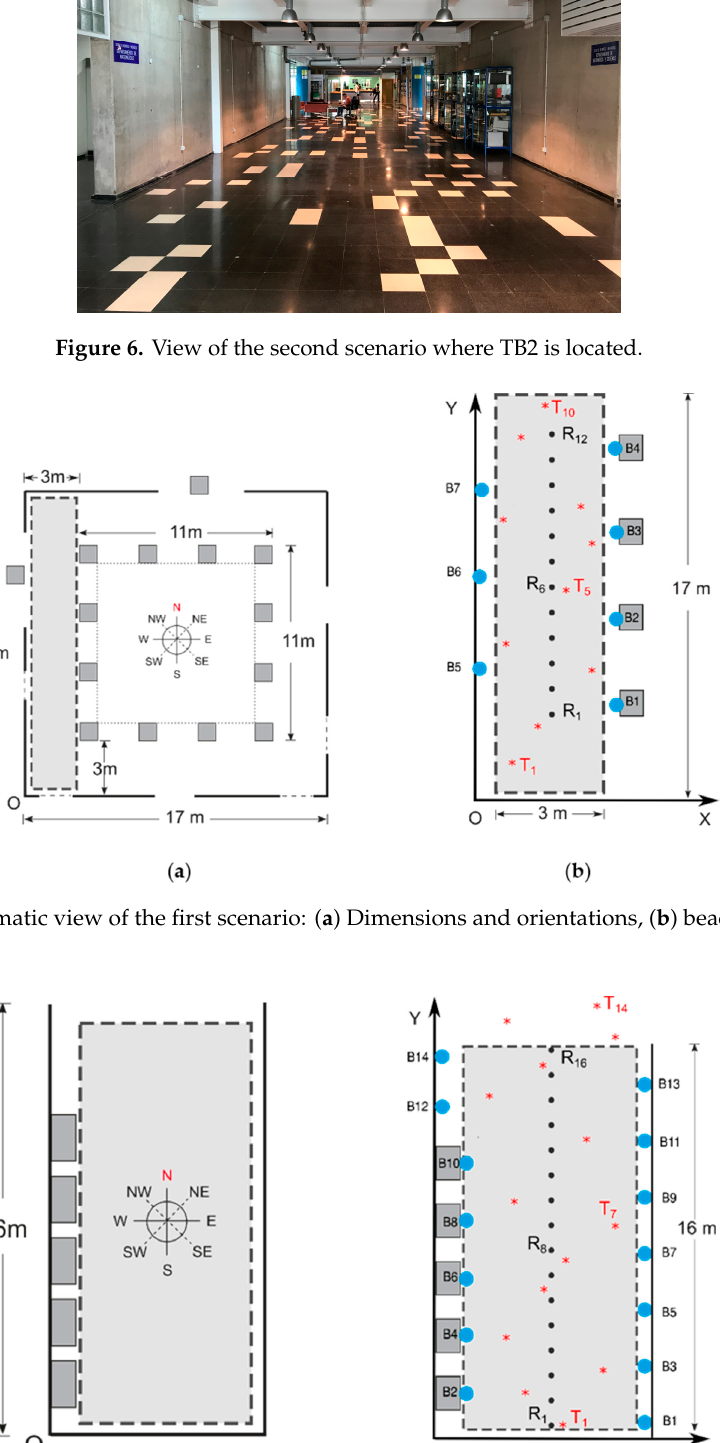
Figure 8. Schematic view of the second scenario: ( a ) Dimensions and orientations, ( b ) beacons, RP and